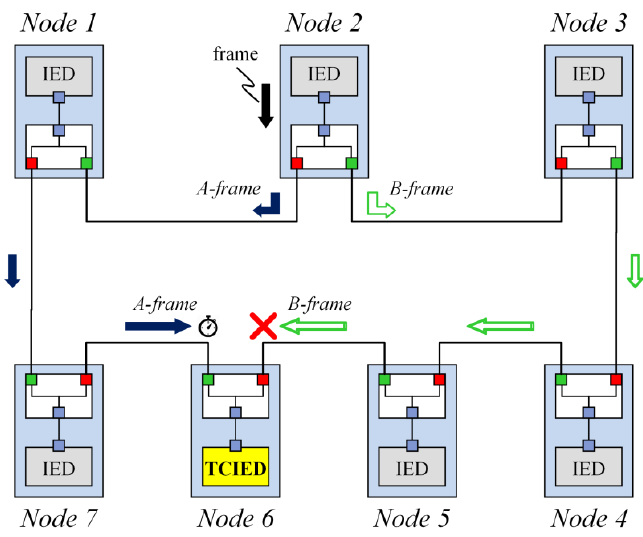
Figure 5. Forwarding frames in the failure-free case under the TC.